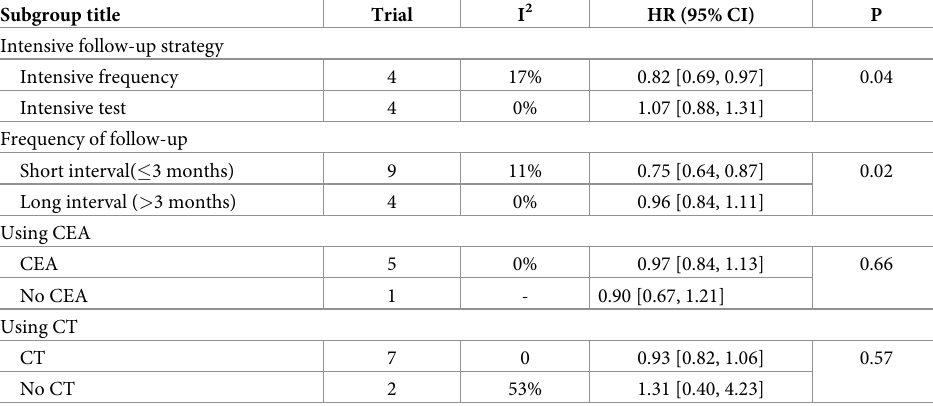
Table 3. Subgroup analysis of the effect of intensive follow-up on overall